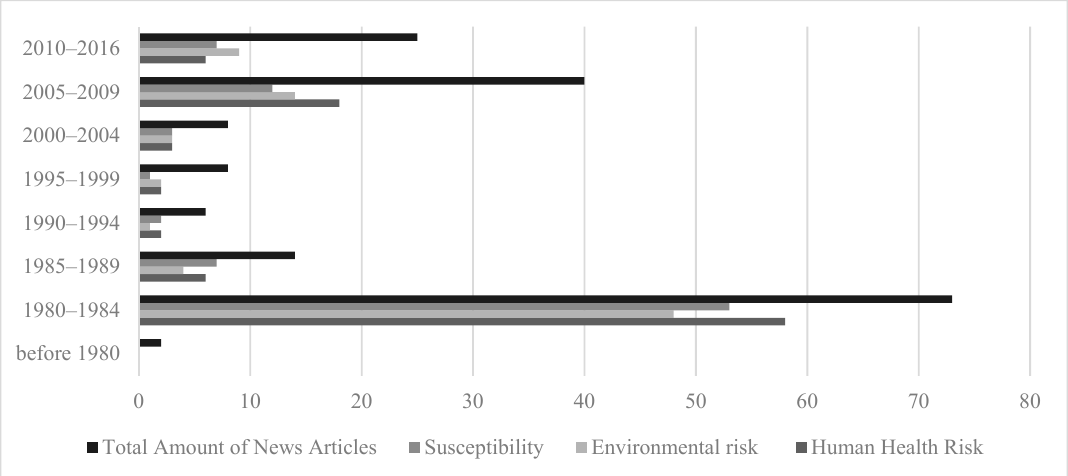
Figure 4. Over-time change in major themes in news coverage.